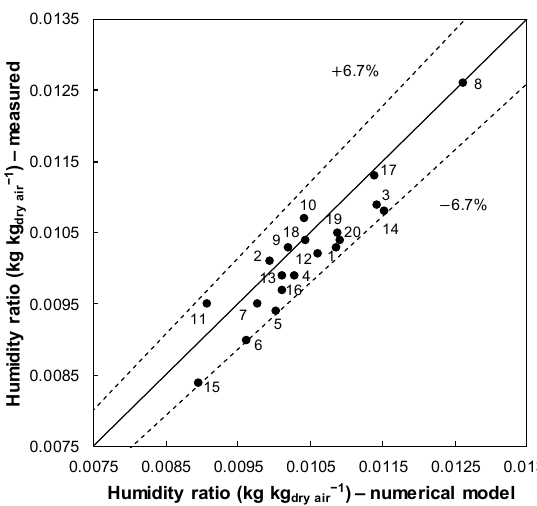
Figure 5. Numerical model predictions vs. experimental measurements of the supply air outlet humidity ratio.